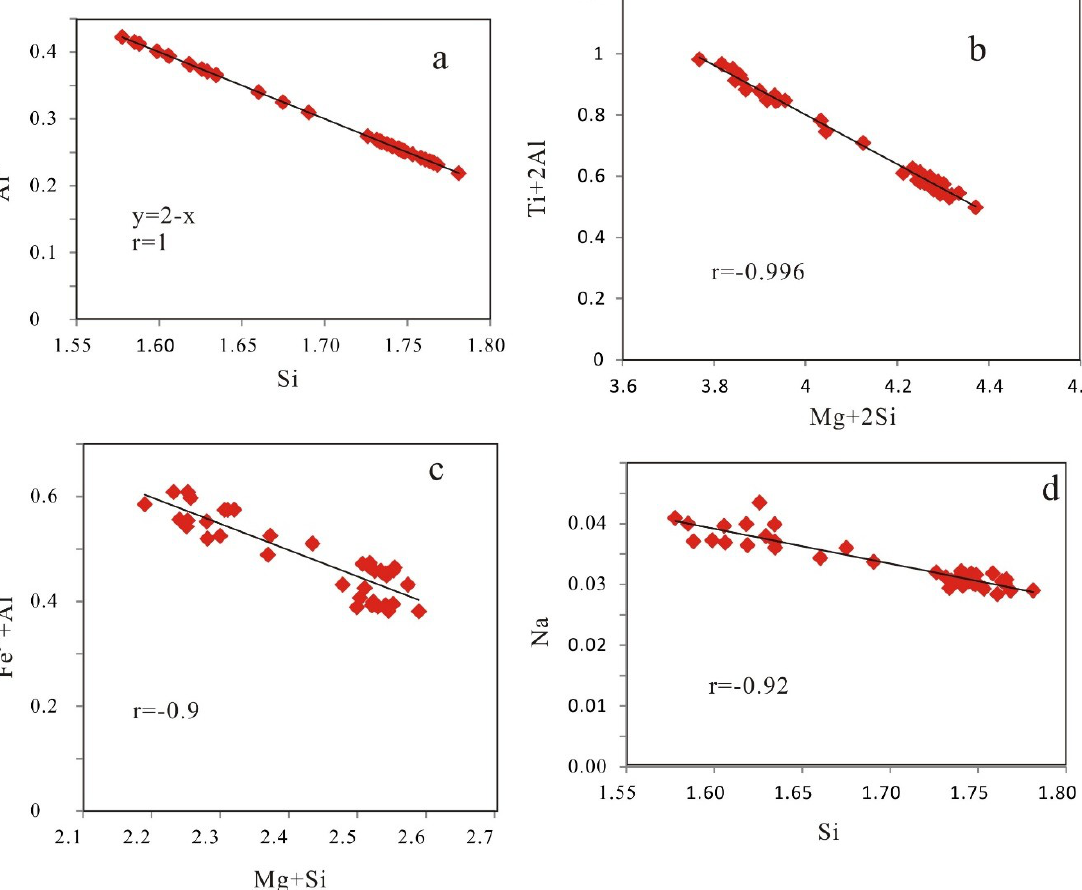
Figure 9. Element isomorphic replacements in the clinopyroxenes from Well CK-2 (based on 6 oxygen atoms). (a) Al IV vs Si; (b) Ti+2Al vs Mg+2Si; (c) Fe 2+ vs Mg+Si; d: Na vs Si.